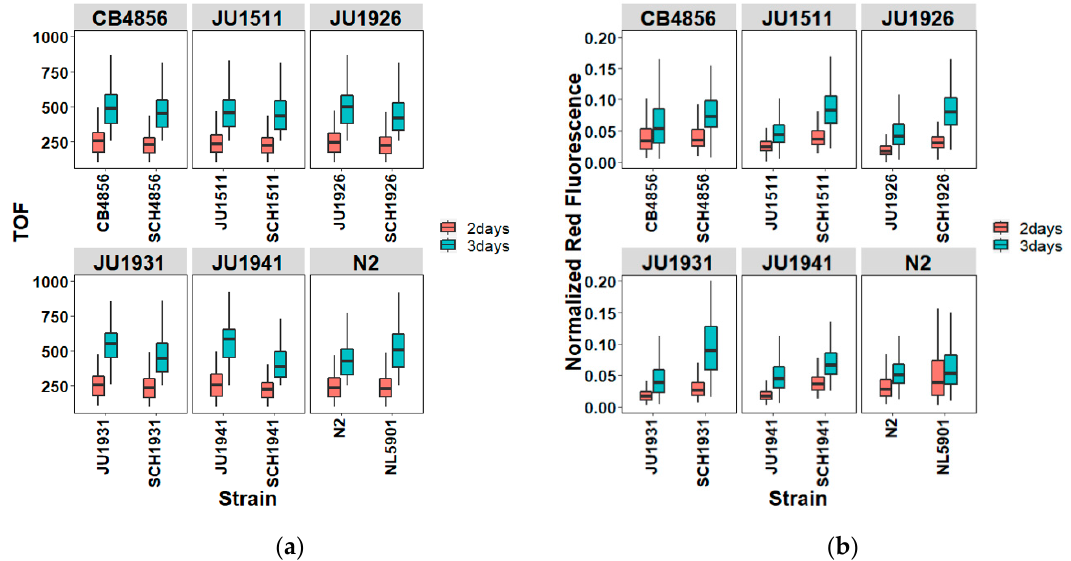
Figure 4. Variation in the body length and Nile Red staining between wild-type worms and their corresponding aS-ILs worms. Both 2-day- and 3-day-old worms were scanned and sorted by the COPAS Biosorter. In total, six di ff erent genetic backgrounds were included. ( a ) Measurements of individual body length (time of flight, TOF). For 2-day-old worms, there was no di ff erence showed depending on genotypes (two-way ANOVA, p = 0.0696, F value = 2.042 with df = 5), but a di ff erence presented between worms with and without α -synuclein (two-way ANOVA, p << 10 − 11 , F value = 45.498 with df = 1). The TOF of 3-day-old worms di ff ered by either genotype or expressing α -synuclein (two-way ANOVA, p << 10 − 11 , F value = 11.577, with df = 5, and p << 10 − 13 , F value = 52.529, with df = 1). ( b ) Measurements of individual Nile Red staining (Normalized Red Fluorescence). A considerably di ff erent fluorescent red signal was a ff ected by genotype in either 2-day- or 3-day-old worms (two-way ANOVA, p << 10 − 16 , F value = 122.60, and p << 10 − 16 , F value = 118.49, respectively, both with df = 5) as well as by α -synuclein (ANOVA, for 2-day-old worms, p << 10 − 16 , F value = 392.69, and for 3-day-old worms, p << 10 − 16 , F value = 701.40; both with df = 1). The variation in the TOF / Nile Red staining exhibits among worms of N2, JUs, NL5901 and α SILs, of which details can be found in the post hoc Tukey tests (Tables S5 and S6). For each treatment and strain, approximately 100–300 worms were